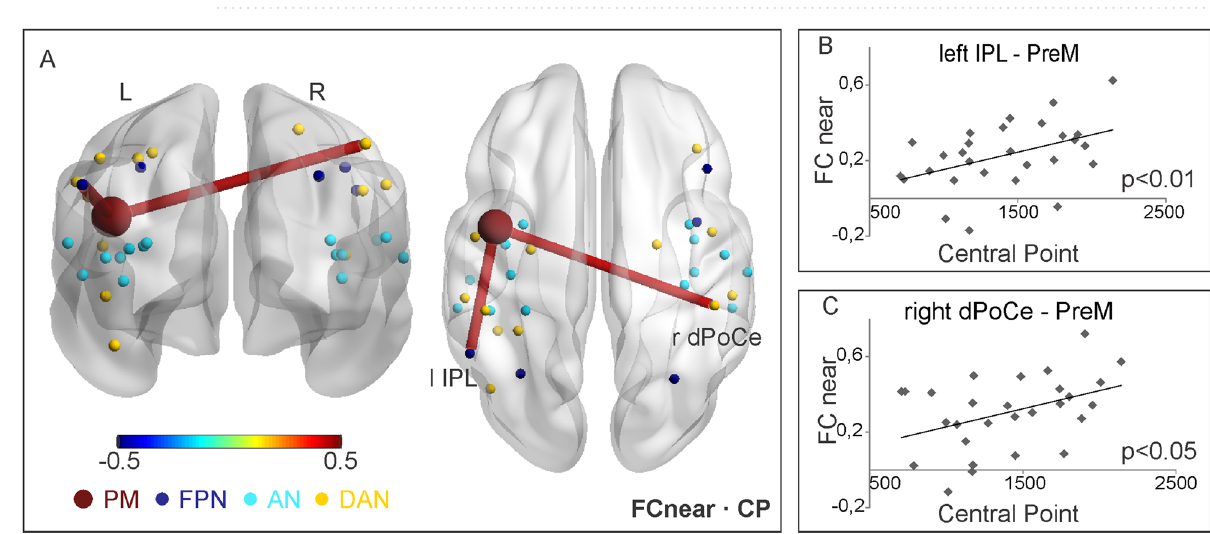
Figure 4. ( A – C ) Results of correlation between FC values and PPS extension (CP), during near condition. Significant correlation coefficients are represented as lines on the standard brain ( A ) and as scatter plots of FC as a function of CP ( B , C